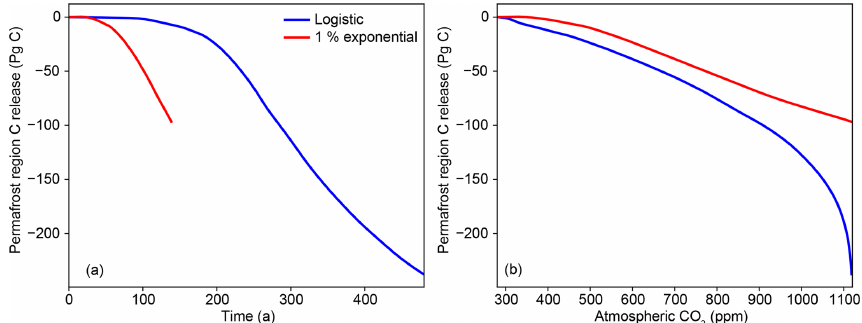
Figure 8. Release of carbon from permafrost region under logistic and 1% experiments. Release include both carbon from the permafrost carbon pool and soil carbon from the overlying active layer. Panel (a) compares the simulations with respect to time, and panel (b) with respect to atmospheric CO 2